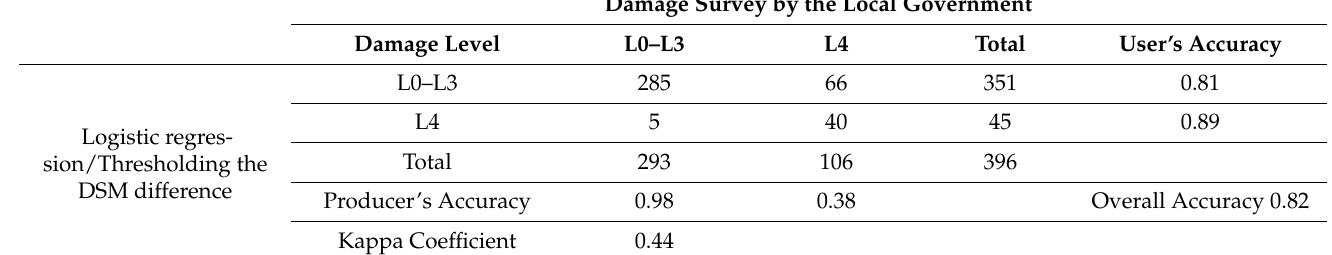
Table 3. Confusion matrix for the extraction of building suffering major (L4) damage using logistic regression and thresholding the DSM